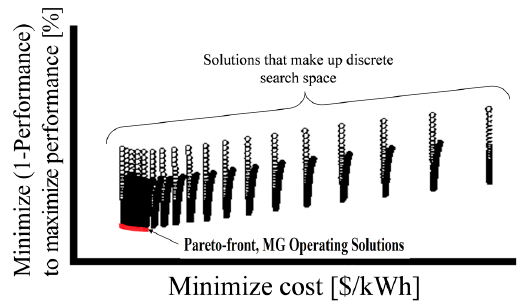
Figure 14. Discrete search space for post-disturbance condition. The objective functions, to minimize cost and maximize performance, form the plot axes. Each circle represents a solution.